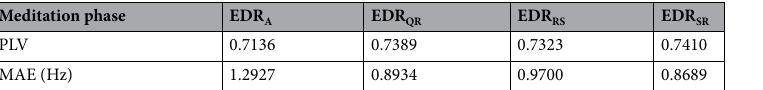
Table 1. EDR evaluation. PLV and MAE between the reference respiration signal and each EDR (EDR A , EDR QR , EDR RS , and EDR SR ). PLV and MAE indicate the phase synchronization and RR estimation error, respectively.